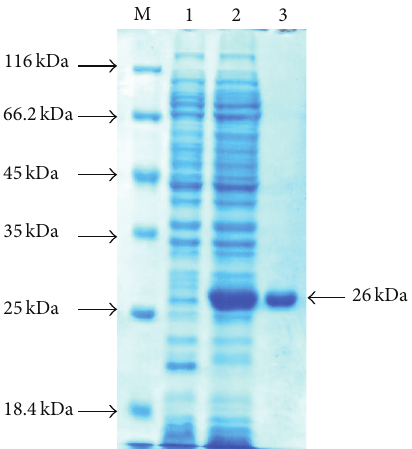
Figure 2: SDS-PAGE analysis of recombinant TssB protein. Lane M: protein molecular weight marker (Fermentas, number SM0431), Lane1:uninducedcontrol,2:IPTGinducedcelllysate,and3:Nickel- NTA affinity column purified